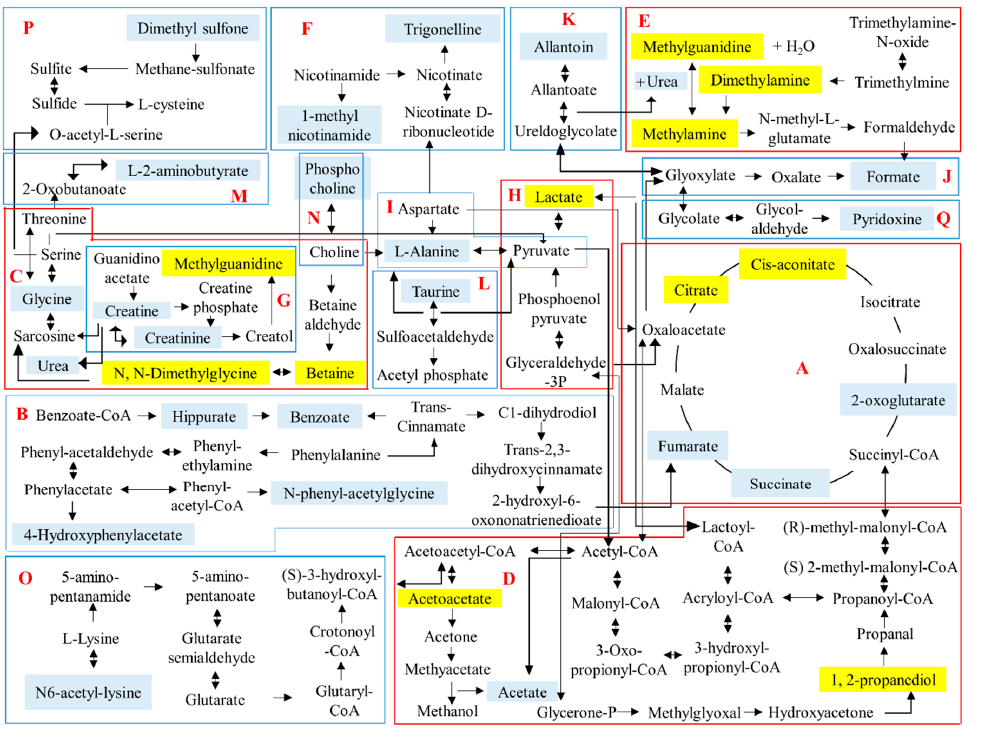
Figure 6. The schematic diagram of the suggested metabolite pathway based on urine collected from both untreated and treated rats. The metabolites highlighted in blue are metabolites successfully identified from the urine of both untreated and treated rats. The metabolites highlighted in yellow are metabolites that showed significantly greater intensities in urine of treated rat collected on Day 1.